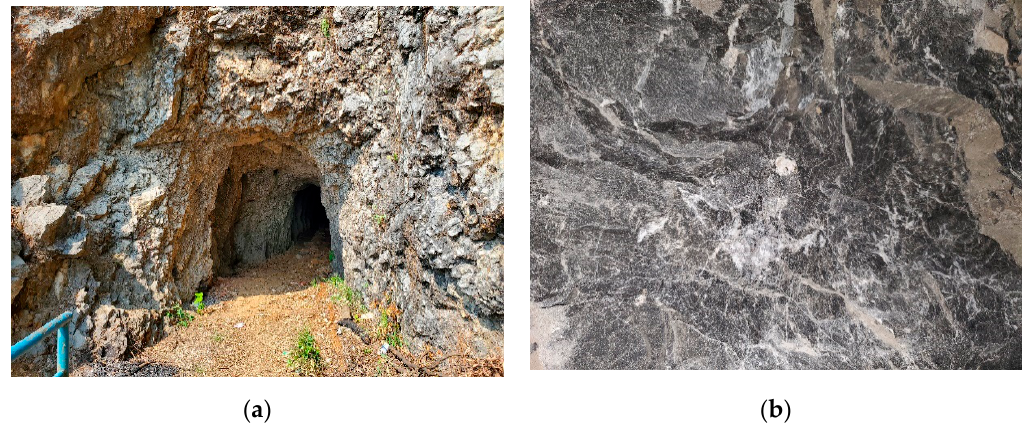
Figure 2. Photos of the surrounding rocks in the entrance and trunk sections: ( a ) surrounding rocks at the portal and ( b ) surrounding rocks in the trunk